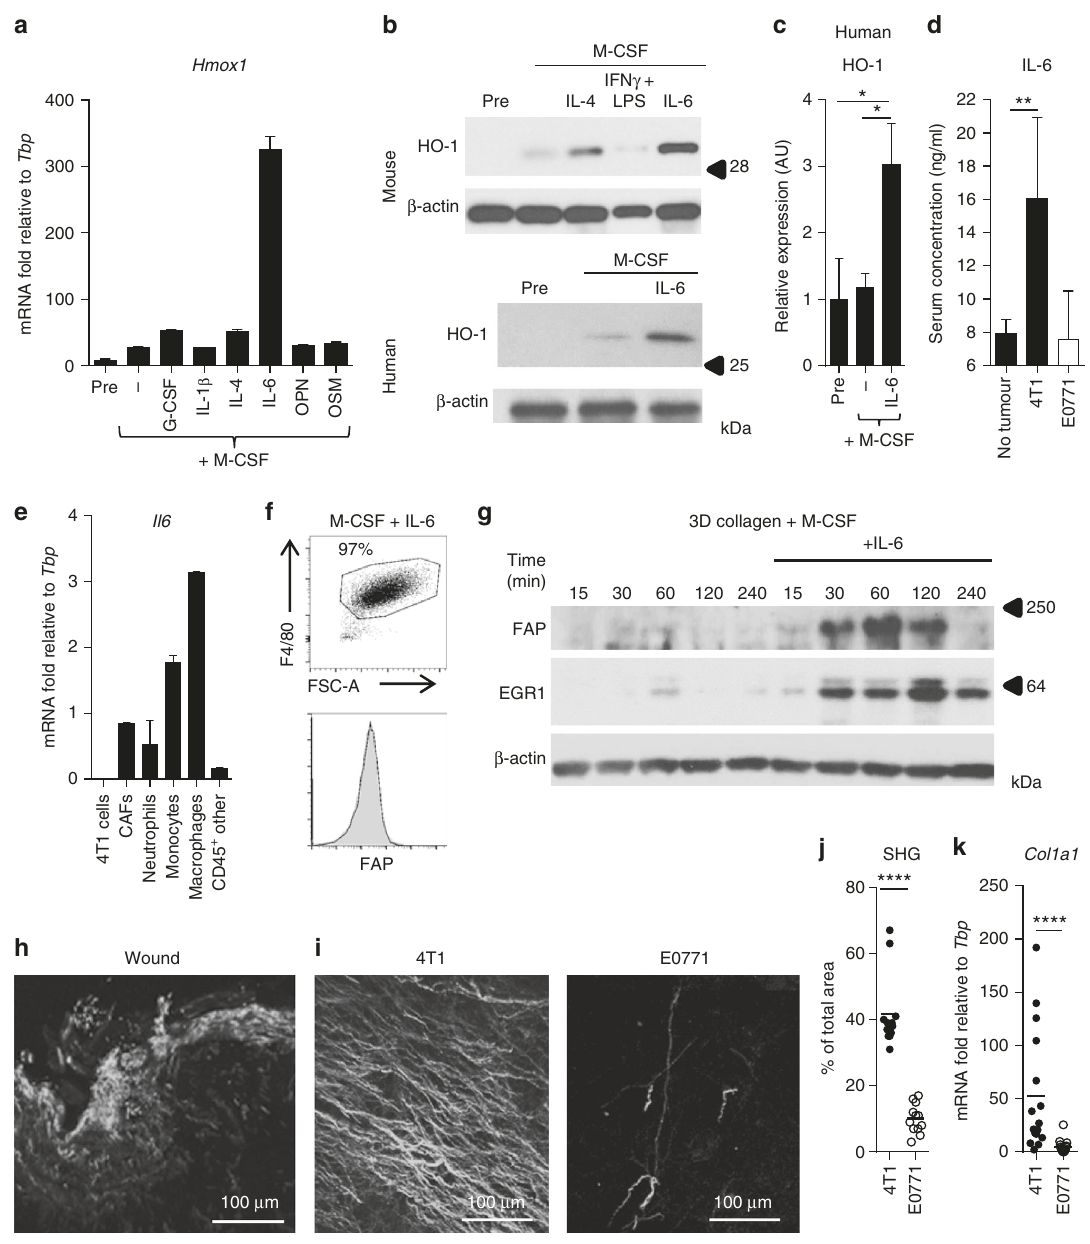
Fig. 4 IL-6 and collagen drive FAP + HO-1 + TAM differentiation in vitro. a Hmox1 mRNA expression relative to the housekeeping gene Tbp in bone marrow- derived (BM) cells before (Pre) and after macrophage differentiation in the presence of indicated cytokines at 50 ng/ml for 72 h ( n = 2 wells; representative of three experiments). b Western blot for HO-1 and the loading control β -actin in BM cells before (Pre) and after 72 h culture in the presence of 50 ng/ml M-CSF with/without 50 ng/ml IL-4, IFN γ + LPS or IL-6 (top) and human peripheral blood (PB)-derived macrophages before (Pre) and after 72 h culture in the presence of 50 ng/ml M-CSF with/without 50 ng/ml IL-6 (bottom). c Quantitation of HO-1 expression in human PB-derived macrophages from individual healthy volunteers ( n = 5) as described in b . d Serum IL-6 concentrations in tumour-free mice and in those bearing late stage (>20 days post inoculation) 4T1 (black) or E0771 (white) tumours ( n = 5) as determined by ELISA. e Representative Il6 mRNA expression relative to Tbp in FACS-sorted tumoural cell populations from a 4T1 tumour ( n = 2 wells, representative of duplicate experiments). f Representative gating, purity and FAP surface expression of BM cells cultured for 72 h in the presence of 50 ng/ml M-CSF and IL-6. g Representative western blot analysis for FAP (top), EGR1 (middle) and β -actin (bottom) in BM cells cultured for 72 h with 50 ng/ml M-CSF with/without 50 ng/ml IL-6, and subsequently incubated for indicated times on 3D murine type I collagen. h , i Representative images of second-harmonic generation (SHG) imaging of fi brillar collagen in frozen sections of wounded skin ( h ) and of 4T1 and E0771 tumours ( i ). j Quantitation of SHG signal in 4T1 and E0771 tumours ( n = 12 tumours (>20 days post inoculation) in each group; average across multiple fi elds of view). k Col1a1 mRNA expression relative to Tbp in 4T1 ( n = 16) and E0771 ( n = 18) tumours (>20 days post inoculation). Bar charts are presented as mean + s.d. * P ≤ 0.05, ** P ≤ 0.01, **** P ≤